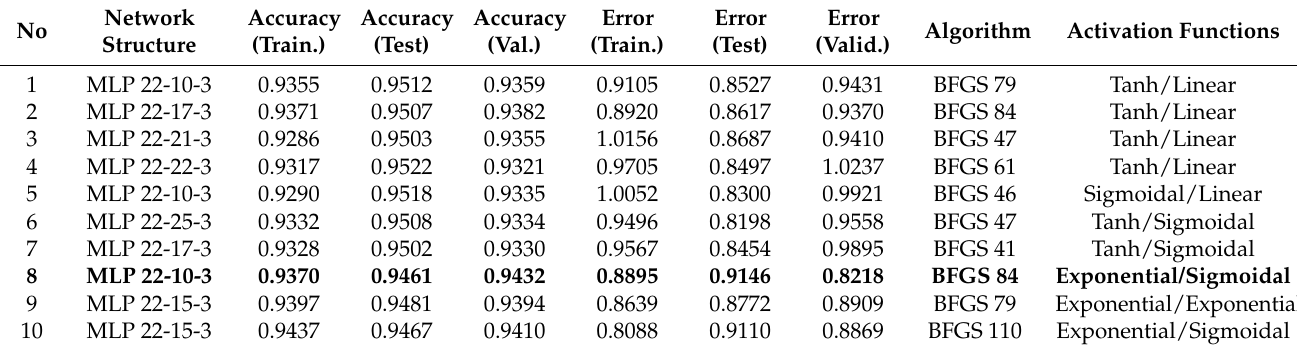
Table 5. List of the artificial neural network with 12 input variables.